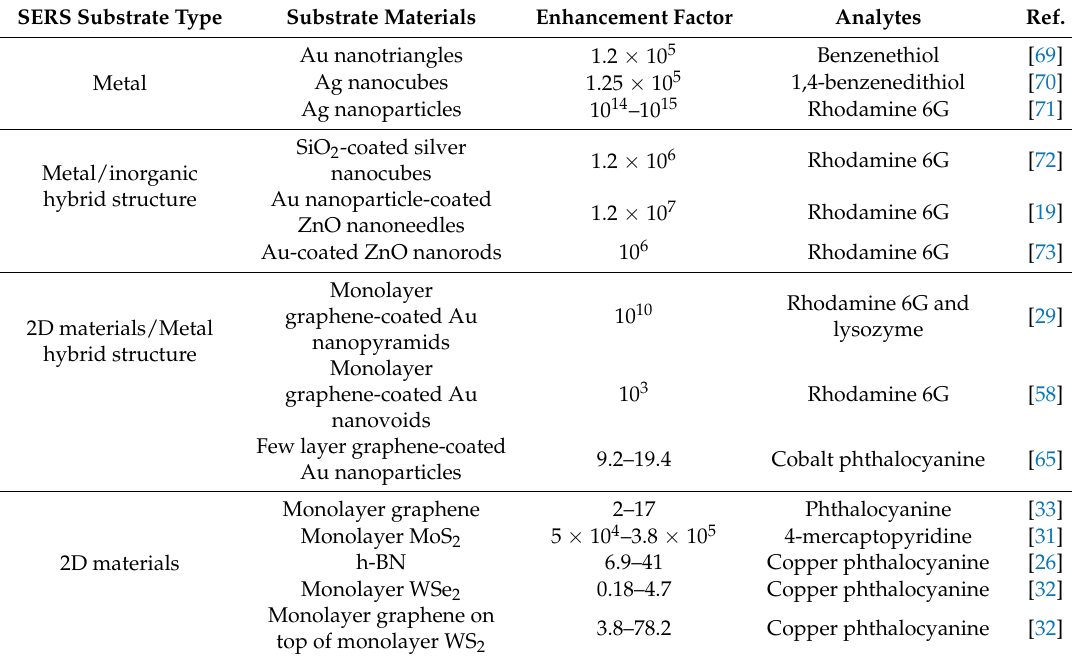
Table 1. Comparisons of typical types of SERS